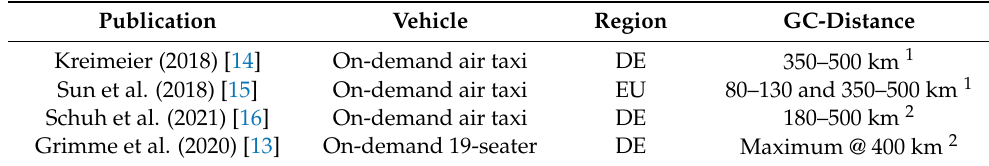
Table 1. Overview of existing research and their derived distance